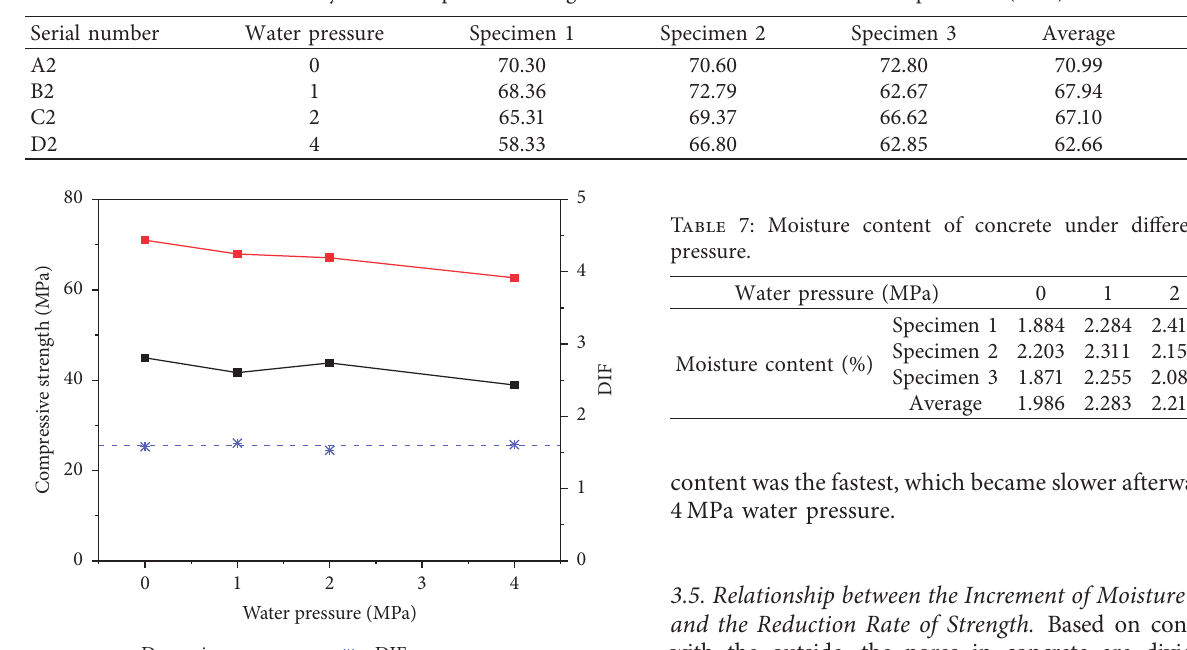
Table 6: Dynamic compressive strength of concrete under different water pressures (MPa).